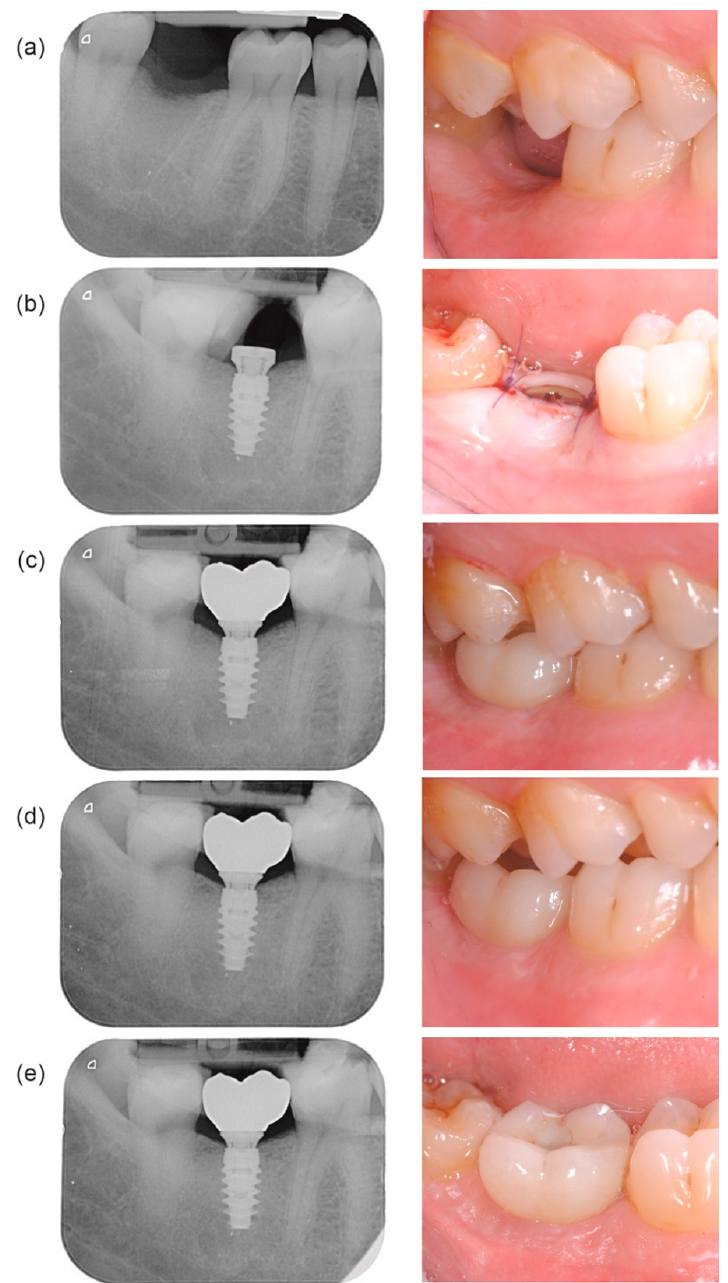
Figure 2. Sample clinical case from the study. Apical radiographs and clinical views acquired pre- surgery ( a ), at implant placement ( b ), at final prosthesis delivery (( c ), left panel), 3 months later (( c ), right panel), and 6 and 12 months after prosthetic delivery (( d , e ), respectively).